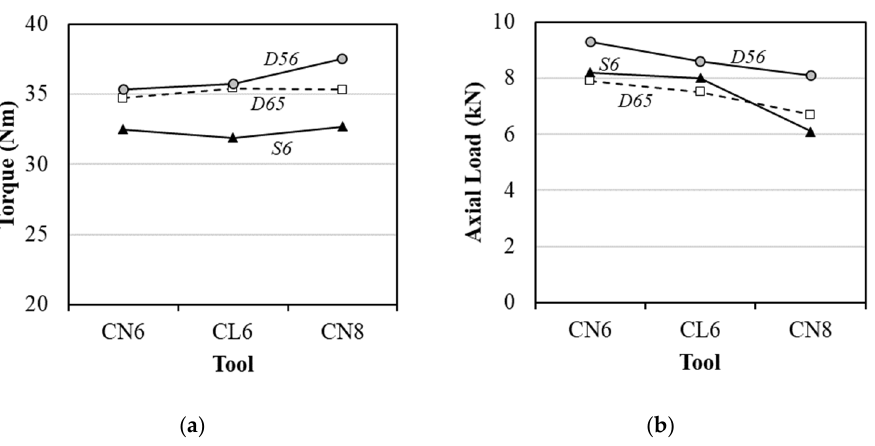
Figure 8. FSW machine output parameters: ( a ) torque and ( b ) axial load.